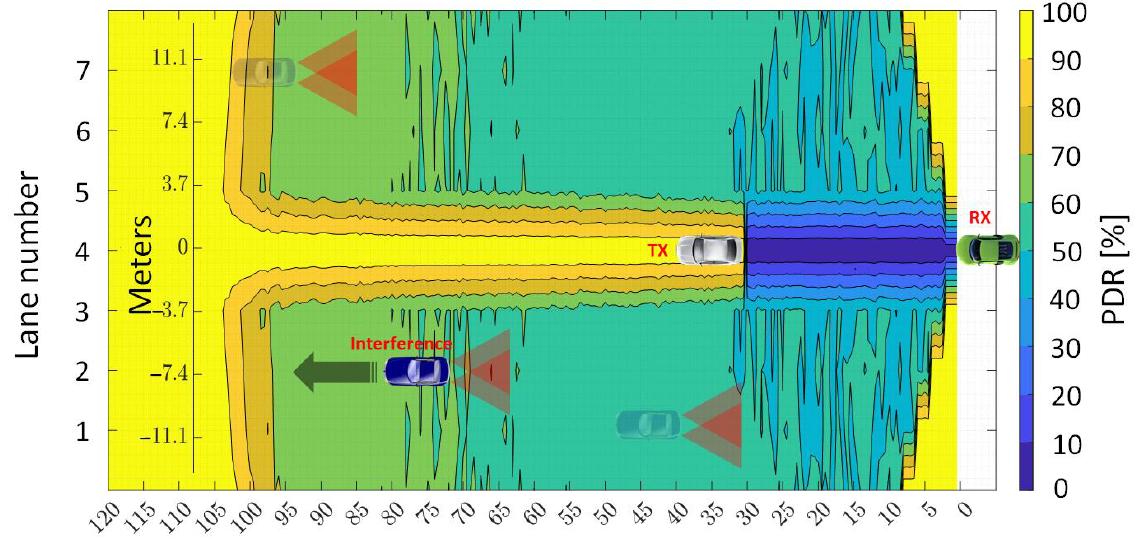
Figure 5. Simulation results showing the packet delivery ratio mapping for a 7-lane road in neighbor- ing V2V VLC interference conditions.